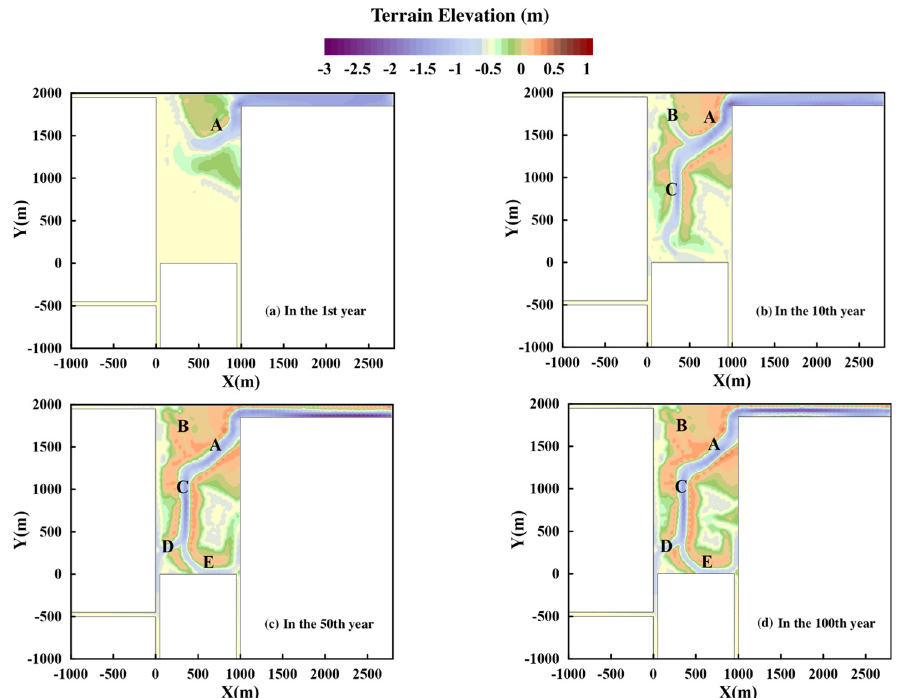
Figure 6. Terrain patterns of the ideal model of Qilihai Lagoon system in ( a ) 1st year, ( b ) 10th year, ( c ) 50th year, and ( d ) 100th year for the control group.